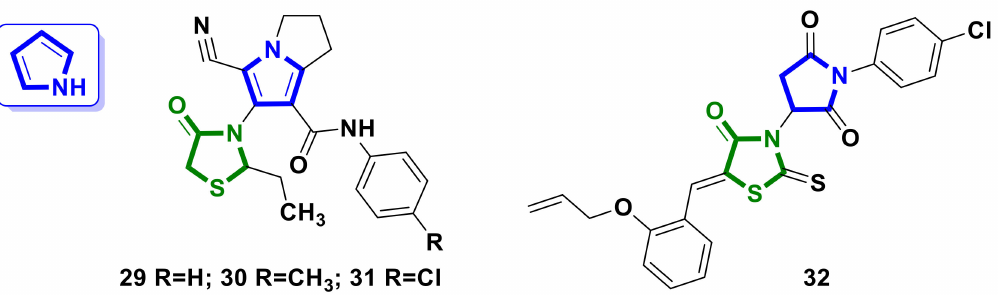
Figure 13. Structures of pyrrole-bearing hybrid molecules with 4-thiazolidinone scaffolds as potential anticancer